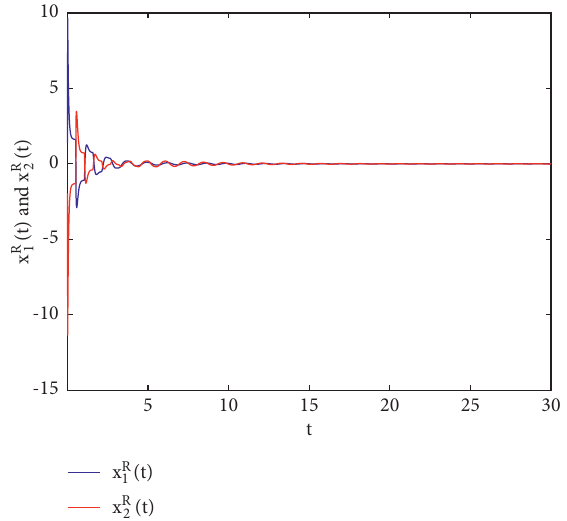
Figure 5: Real parts of the transient states of system (68) under controller (71).